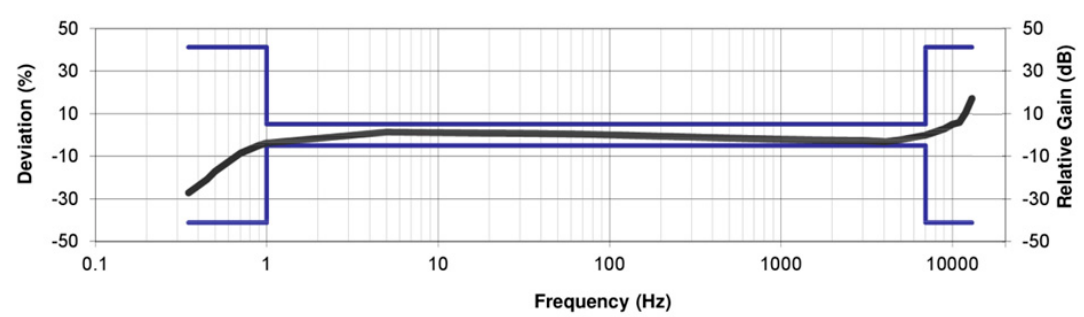
Figure 1. The typical amplitude response curve of a traditional acceleration sensor with high sensitivity (provided by FATRI (Xiamen) Technologies Co., Ltd . ) .